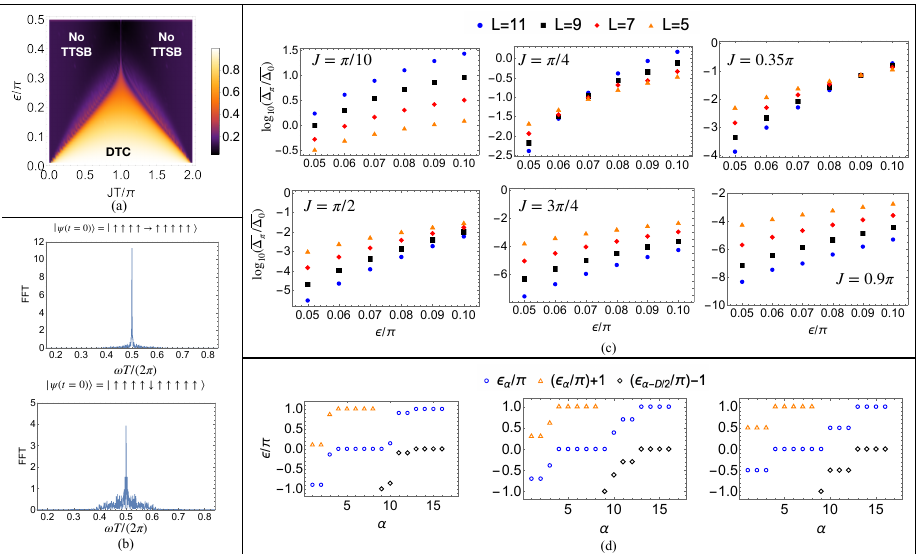
Figure 6. ( a ) Phase diagram of the model obtained from averaging P ( 2 nT ) over 1000 periods for a 10-site system. There is a large region of parameter space where the system exhibits DTC order. ( t ) when the i -th spin is polarized along the + x and − z direction ( b ) The Fourier spectrum of σ z i respectively, while the other spins are polarized along + z direction. It is clear that the system exhibits a sharp Fourier peak at ω = π / T - a direct signature of period doubling oscillations. ( c ) The eigenstate averaged energy gaps defined in Equations (12) and (13) as a function of (cid:101) and J for ∆ → 0 in the thermodynamic limit. It is evident different system sizes L . In the DTC regime, π ∆ 0 from this figure that the transition from the no-TTSB phase to the DTC phase is accompanied by ∆ ∆ a transition from increasing to decreasing with increasing system size. ( d ) Quasi-energy π ∆ π ∆ 0 0 spectrum for a 4-site system when JT = π : there are 4 perfect π -spectrally paired states due to the time reflection symmetry that emerges at this point. These perfect π -spectral pairs would lead to eternal period doubling